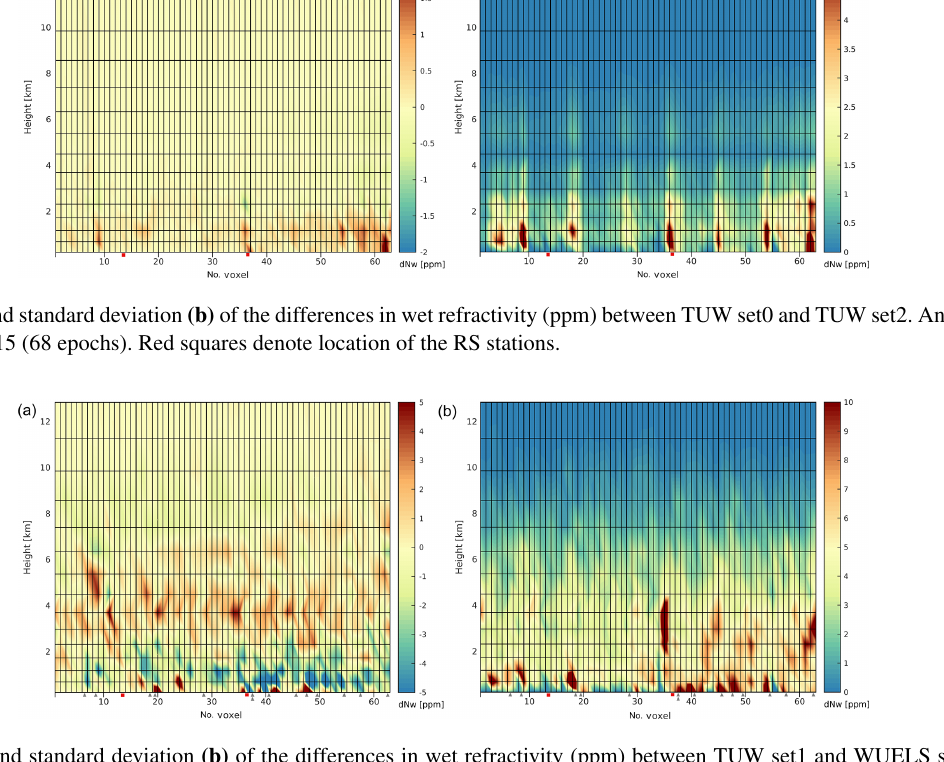
Figure 5. Bias (a) and standard deviation (b) of the differences in wet refractivity (ppm) between TUW set1 and WUELS set1. Analysed period: 29 May–14 June 2013 (68 epochs). Grey triangles denote GNSS stations removed from the specific voxels of the WUELS solution (one triangle stands for one rejected GNSS station), and red squares denote location of the RS